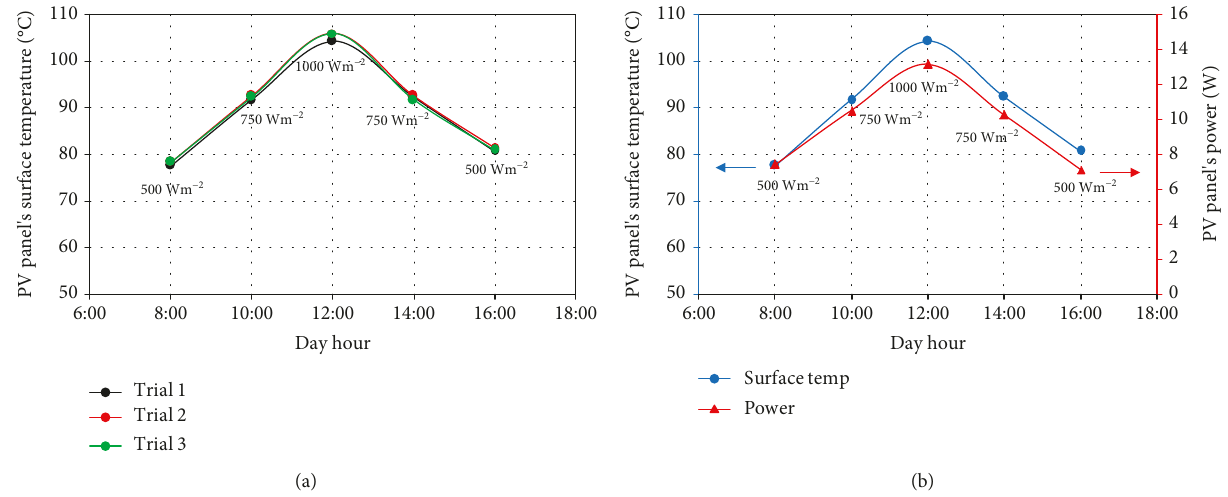
Figure 4: Measurement of the PV panel at three di ff erent solar irradiances to simulate morning, late morning, noon, afternoon, and late afternoon (a) surface temperatures of three trials and (b) average surface temperature and average output power.